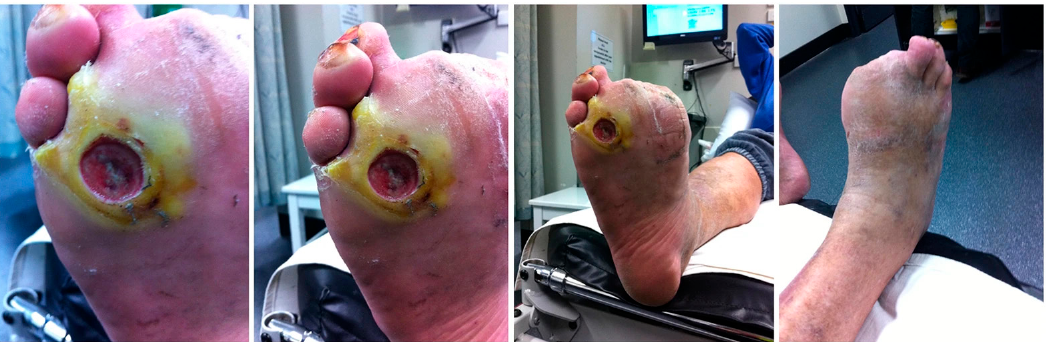
Figure 1. Diabetic Foot ulcer. Figure reused from Netten and co-workers [24]. Used under the creative.